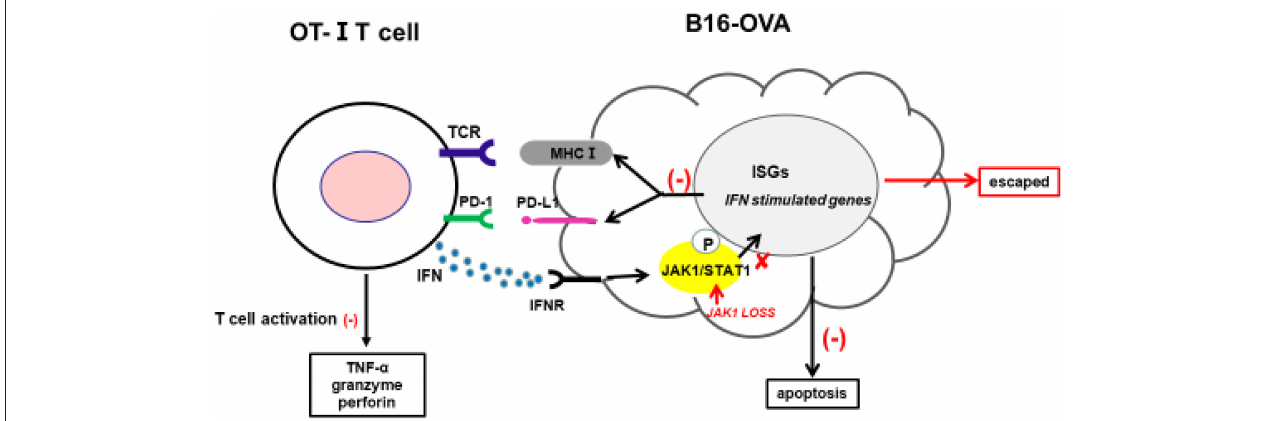
FIGURE 7 | Proposed mechanism by which JAK1 deficiency leads to cytotoxic T-cell resistance. Tumor-derived OT-I–MHC-I complex can activate OT-I T-cells to produce cytotoxic IFN- γ , TNF- α , granzyme, and perforin. IFN- γ can activate JAK–STAT signaling in tumor cells, leading to upregulation of multiple regulatory genes affecting T-cell activation and function. IFN- γ -induced MHC-I can sensitize tumor cells to T-cell-mediated killing, while IFN- γ -induced PD-L1 suppresses T-cell activation by interacting with PD-1 in T-cells.